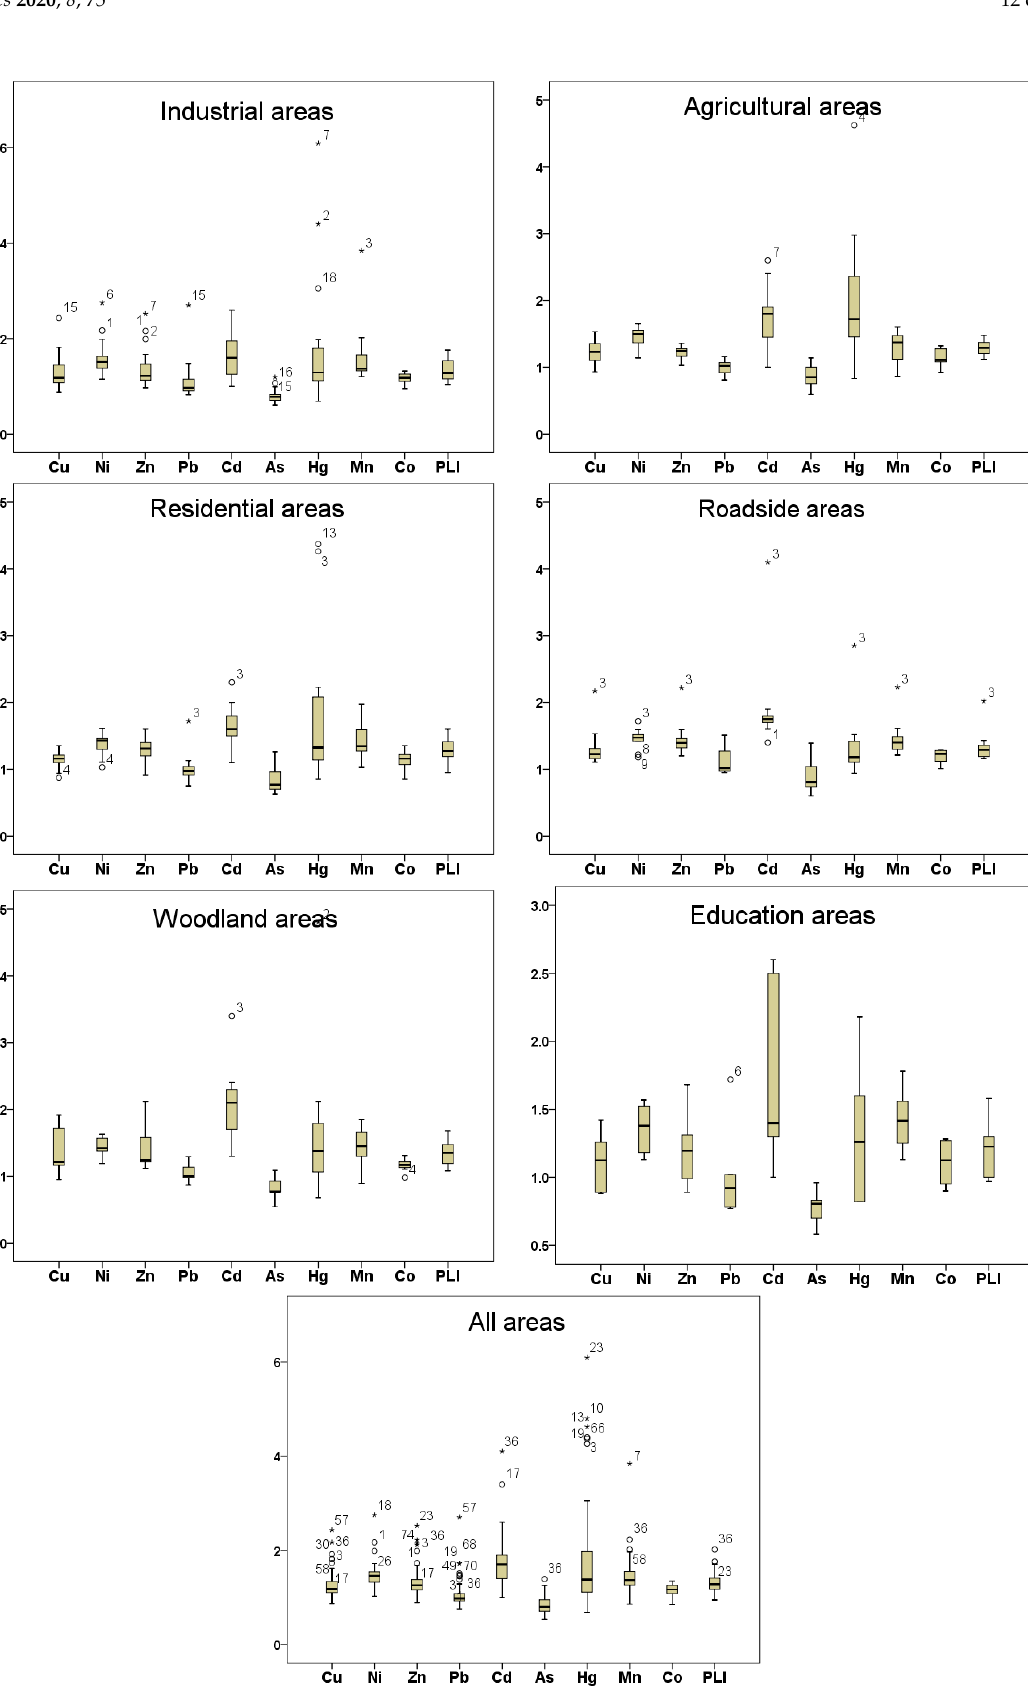
Figure 3. The box-plots of the pollution load index (PLI) values for 9 heavy metals in the six functional areas and all areas. ( x -axes: the PLI values, y -axes: the sample point number of each heavy metal, *: extreme value, discrete value).